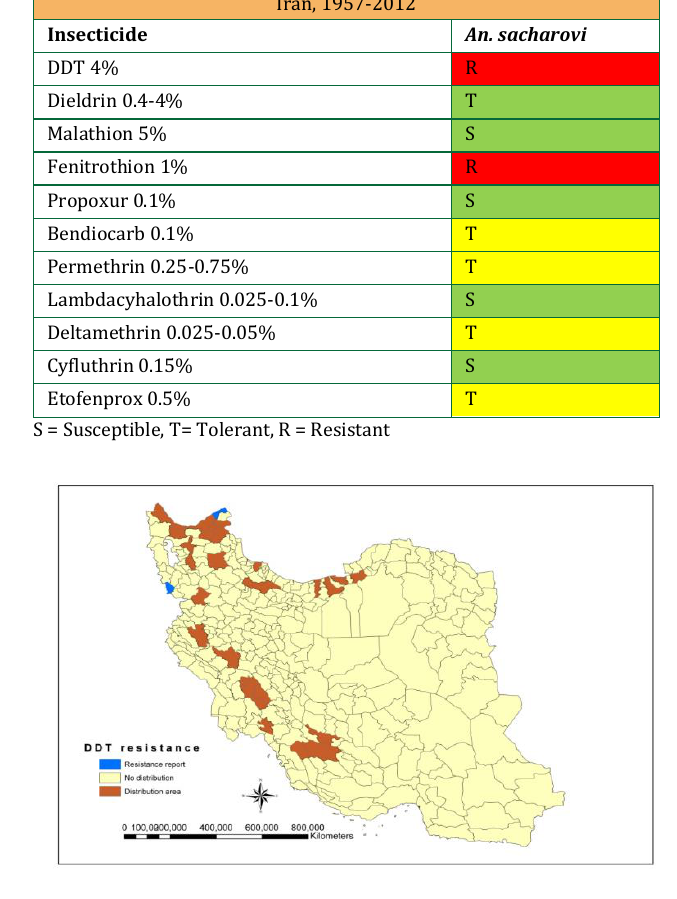
Figure 7: Distribution map of An. sacharovi and spatial distribution of resistance to DDT in Iran, 1997-2010